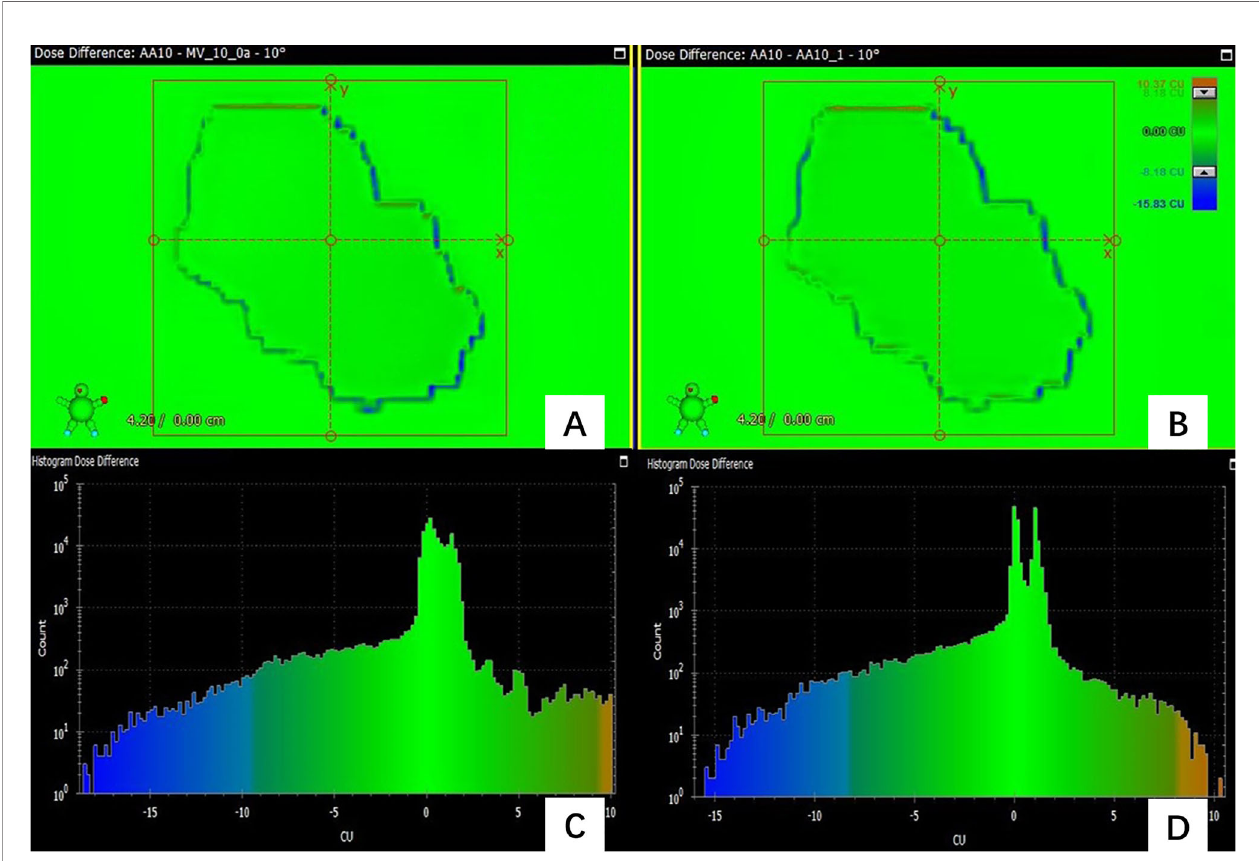
FIGURE 5 | (A) the dose difference between the measured planar dose and TPS calculated (B) the dose difference between the predicted and TPS calculated planar dose. (C) the histogram of the dose difference between measured and TPS calculated planar dose for one failed fi eld (D) the histogram of the predicted planar dose relative to TPS calculated